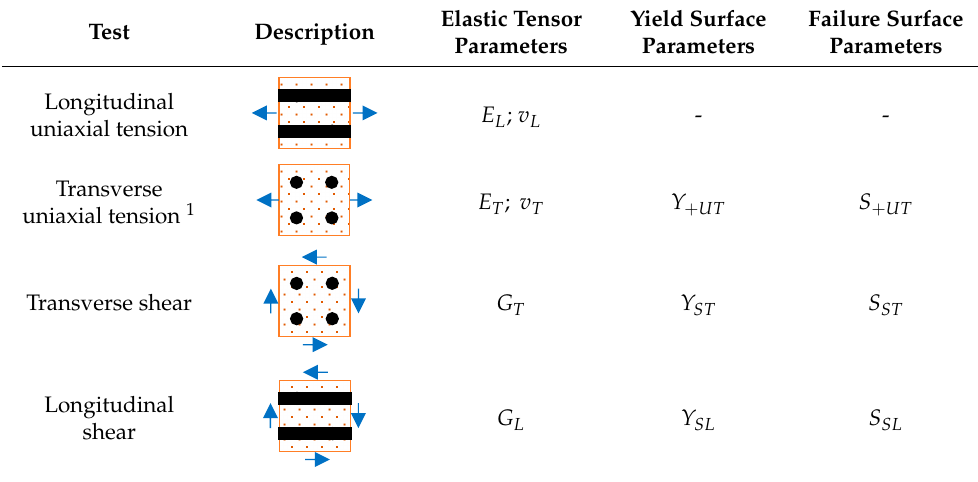
Table 3. Loading cases to identify the effective composite